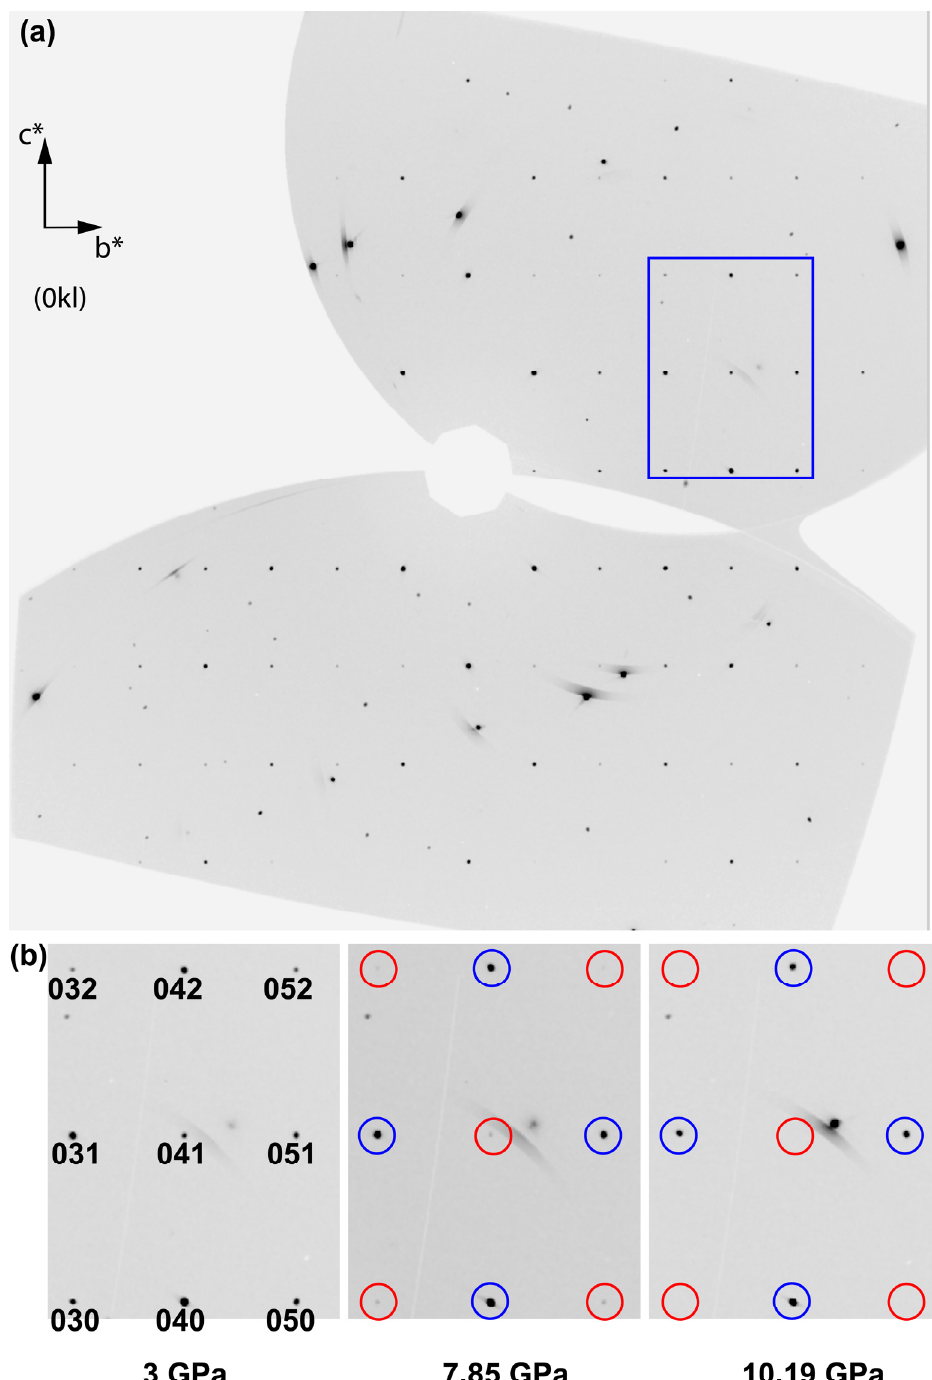
Figure 3. ( a ) Single crystal di ff raction precession image of δ -AlOOH along the 0kl . The blue square shows the area that was enlarged in Figure 3b. ( b ) The enlarged single crystal di ff raction precession images of δ -AlOOH of the 0kl section at di ff erent pressures. “*”—designate vectors of reciprocal